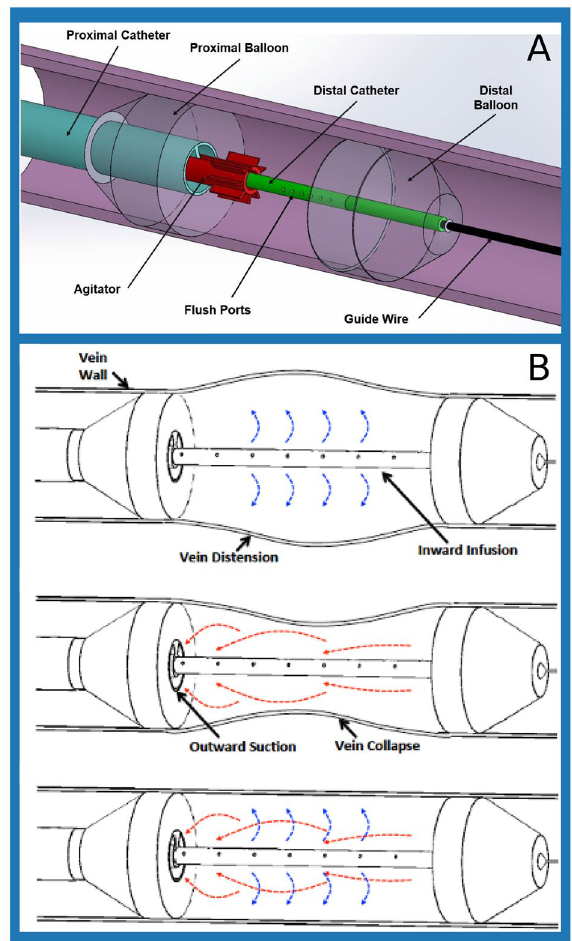
Figure 2. ( A ) Components of the multi-modal sequestering thrombectomy catheter that isolates the treatment zone. ( B ) Comparison of infusion only, suction only, and infusion and suction modes of catheter operation to evacuate thrombus fragments within the isolated treatment